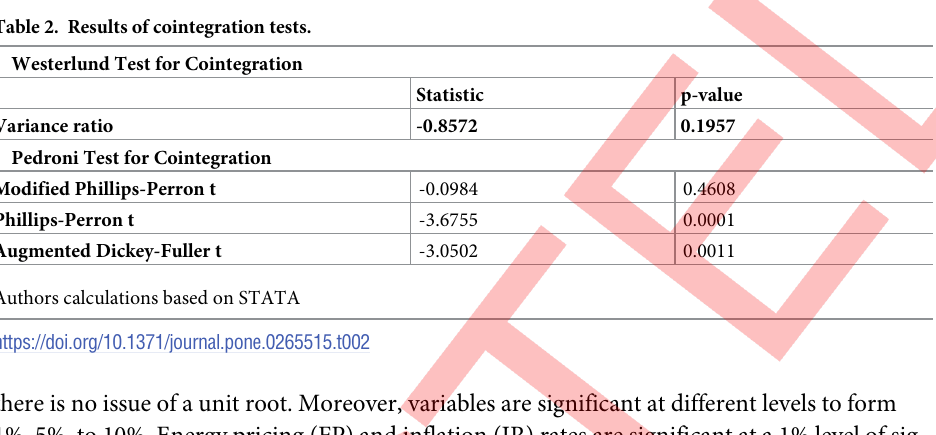
Table 2. Results of cointegration tests.